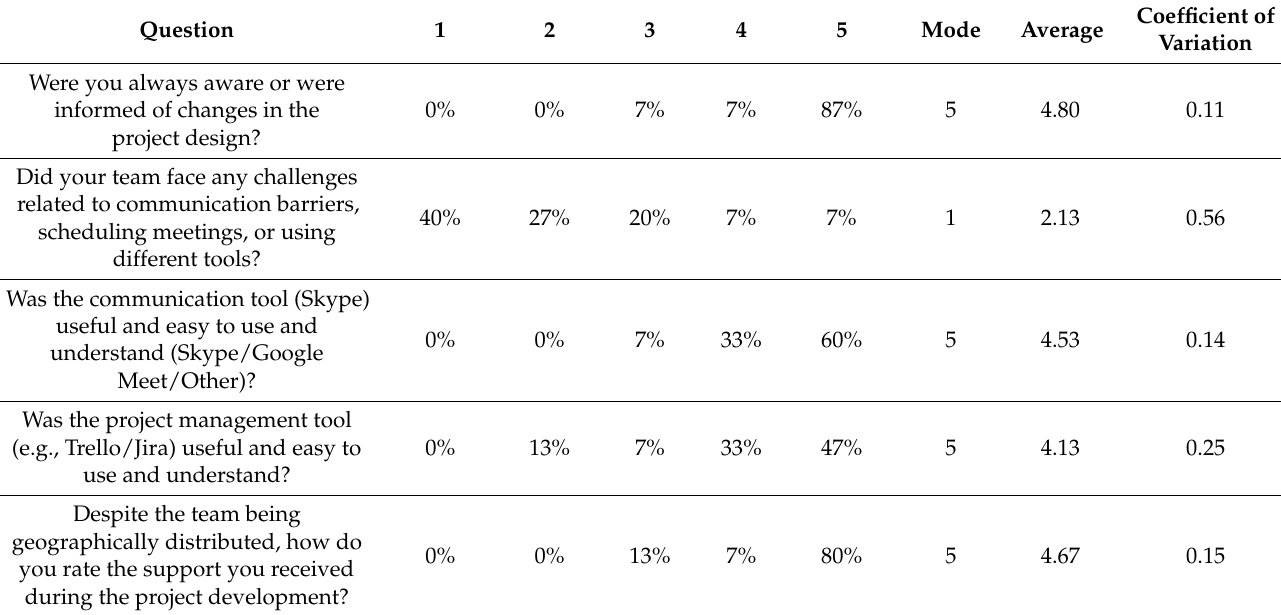
Table 7. Scrum and OutSystems vs. distributed